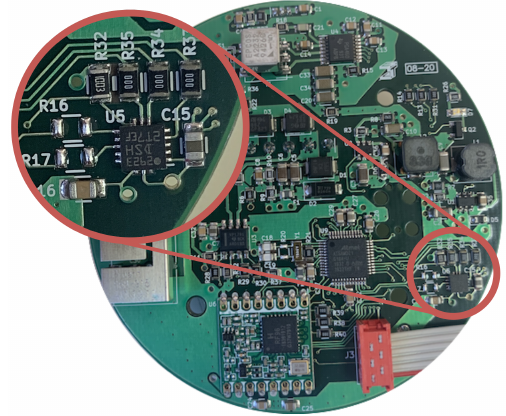
Figure 5. Board used during the calibration